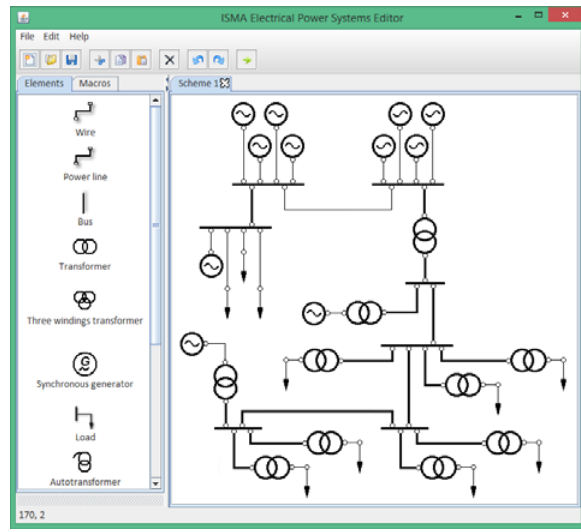
Fig. 6. ISMA’s EPS editor .